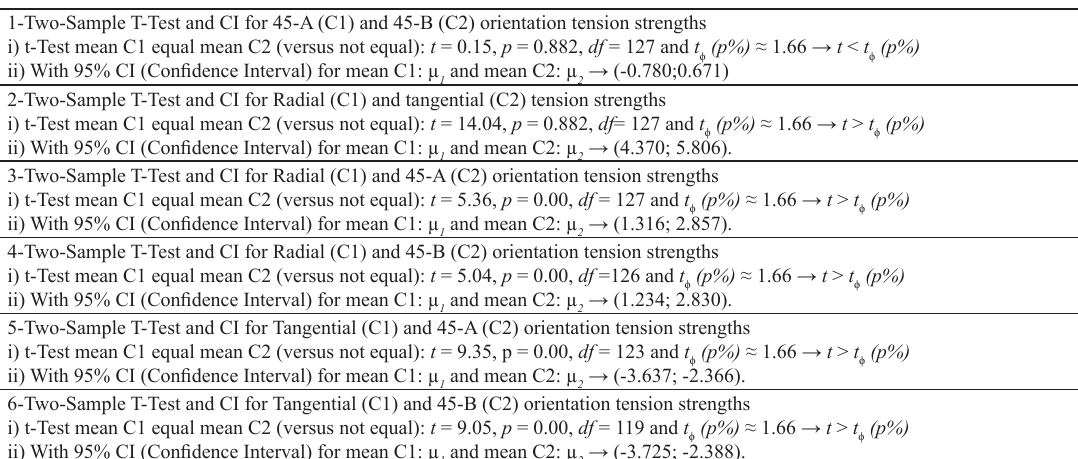
Figure 10. Boxplot of Radial, Tangential and 45-degree (A and B) Orientation Tension Table 4. Two-Sample t-Test and CI (Confidence Interval) Results.